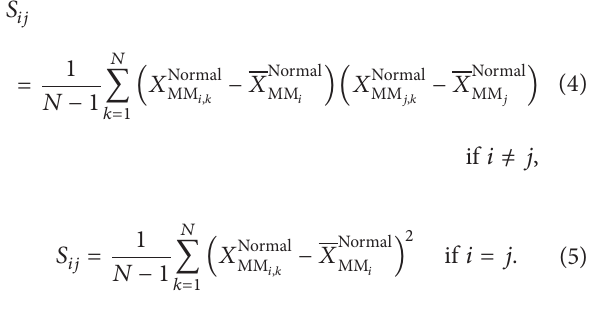
Algorithm 1. TSD values of each profile are used for calcu- lating mean (𝜇 TSD ) and standard deviation (𝜎 TSD ) as given in the algorithm. These values are employed in calculating the threshold range using central limit theorem. The calculated threshold range is used in the attack detection module. Algorithm 1 (MHT 2 S). Consider the